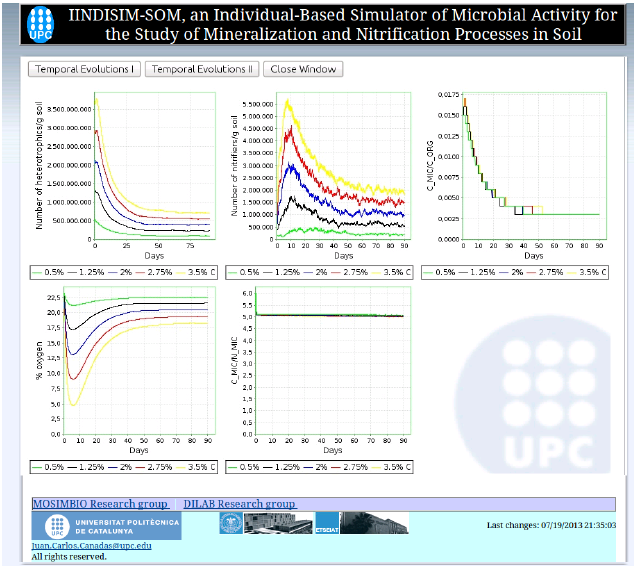
Figure 1. Temporal evoluton of microbial variables, for virtual soils with 0.5, 1.25, 2.0,